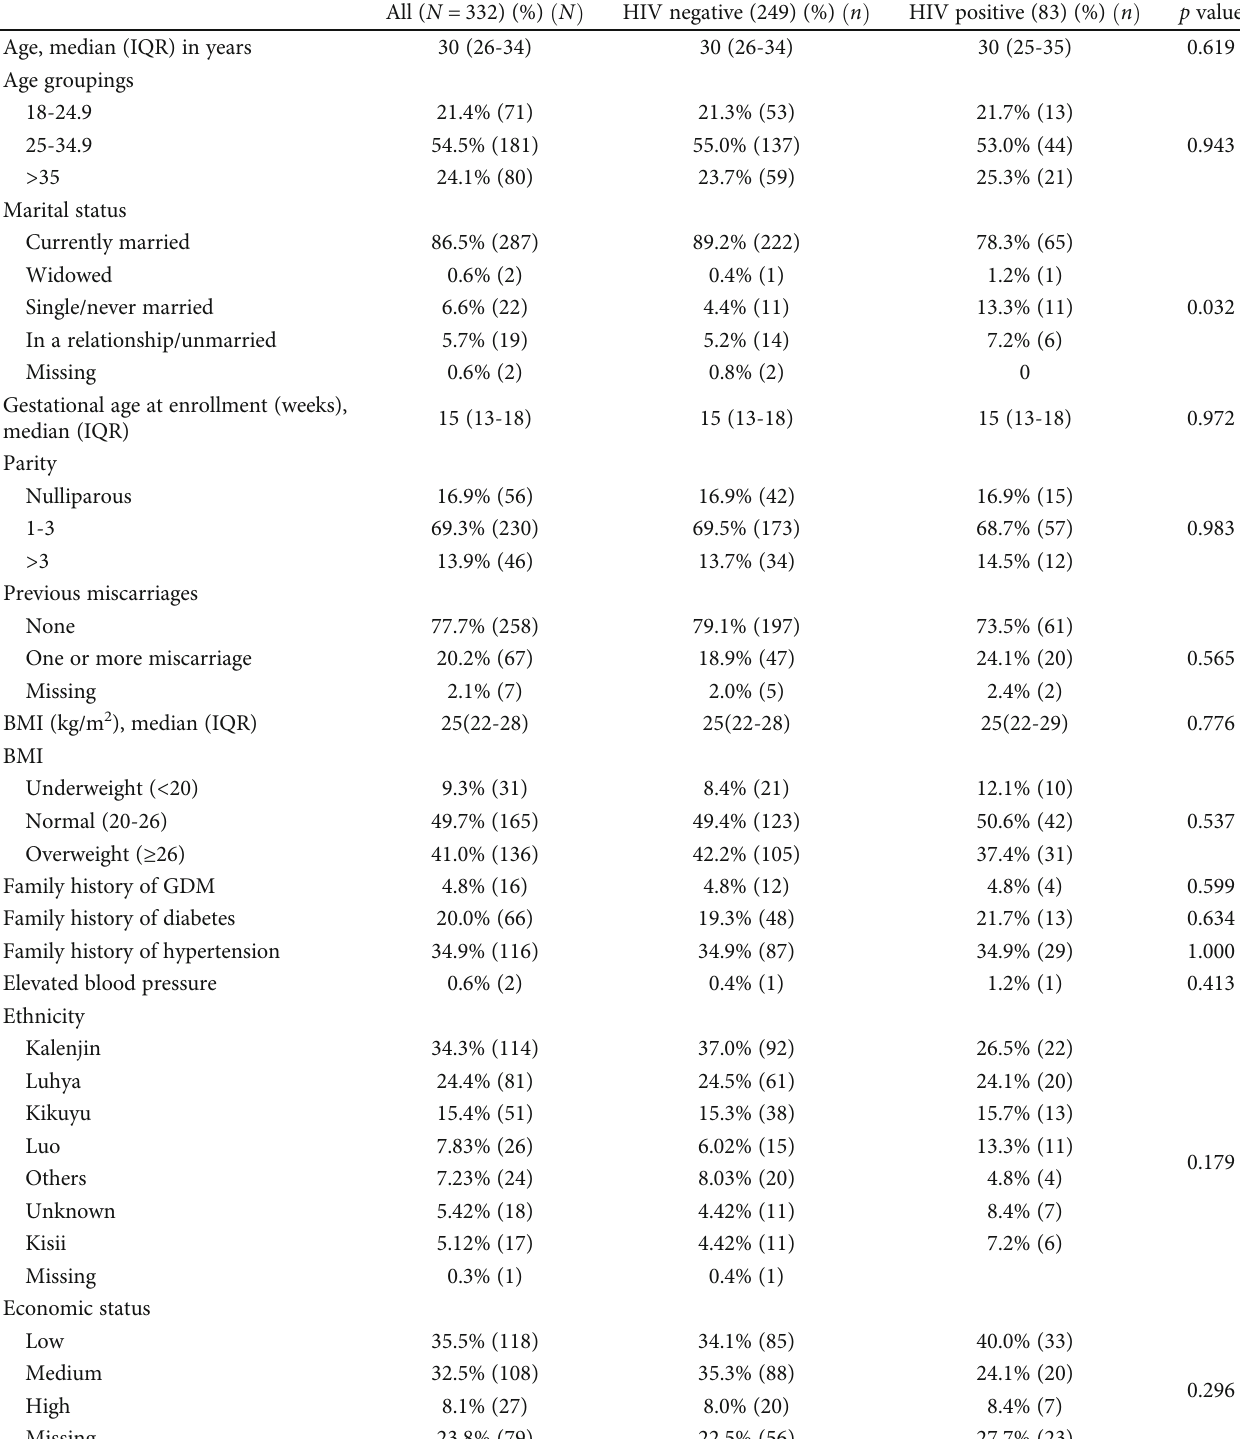
Table 1: Baseline